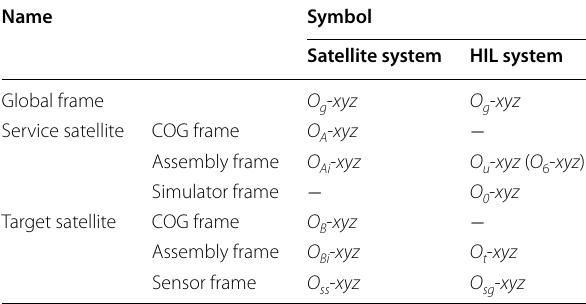
Table 1 Comparisons of coordinate